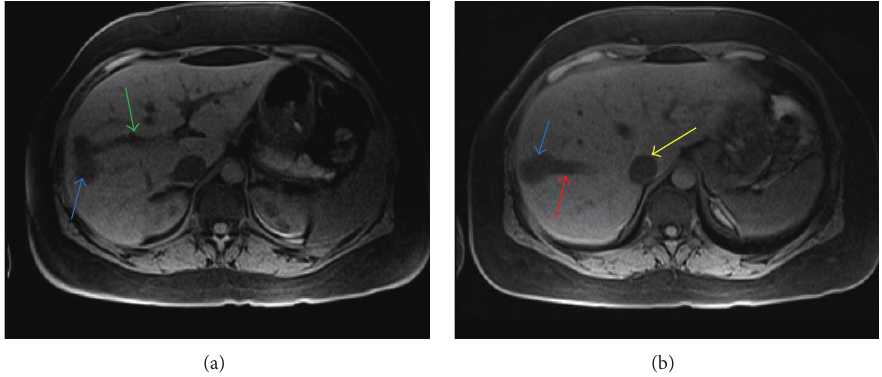
Figure 2: A 45-year-old female with intrahepatic portosystemic venous shunt with associated aneurysms. (a) Noncontrast axial VIBE MRI image showing communication between the right portal vein (green arrow) and right hepatic vein through an aneurysm (blue arrow). (b) Noncontrast axial VIBE MRI image (a few sections cranial to (a)) demonstrating communication between the right portal vein and right hepatic vein (red arrow) through a second larger aneurysm (blue arrow). Protocol: Siemens, 1.5 Tesla Avanto MR Scanner, TR = 4.3, TE = 1.91, 3.5 mm slice thickness, Matrix = 192 × 256, no contrast.